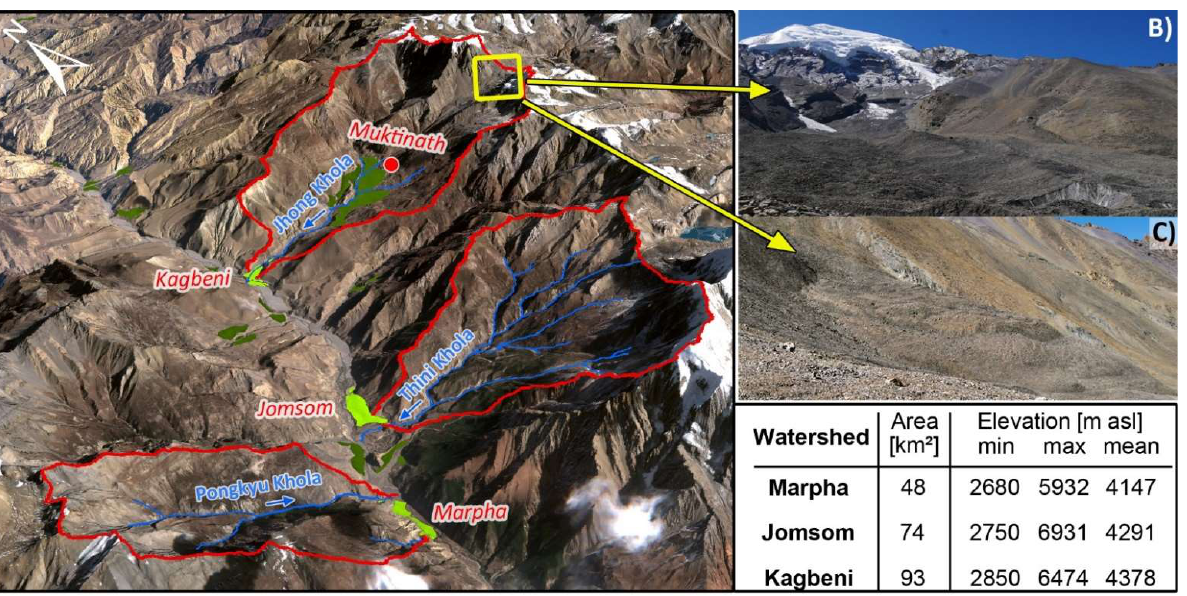
Figure 3. ( A ) Alpine catchments (red) of the major tributaries (blue) Pongkyu, Thini, and Jhong Khola and location of irrigated fields in Marpha, Jomsom, and Kagbeni (light green; dark green represents irrigated fields of other settlements). Background imagery: Sentinel-2 [79] RGB-composite; acquisition date: 28 December 2015. ( B ) Thermokarst appearances at debris-covered glacier and ( C ) rock glacier in the Upper Jhong-Khola catchment indicating the presence of below surface ice below at an elevation of 5000 m asl.